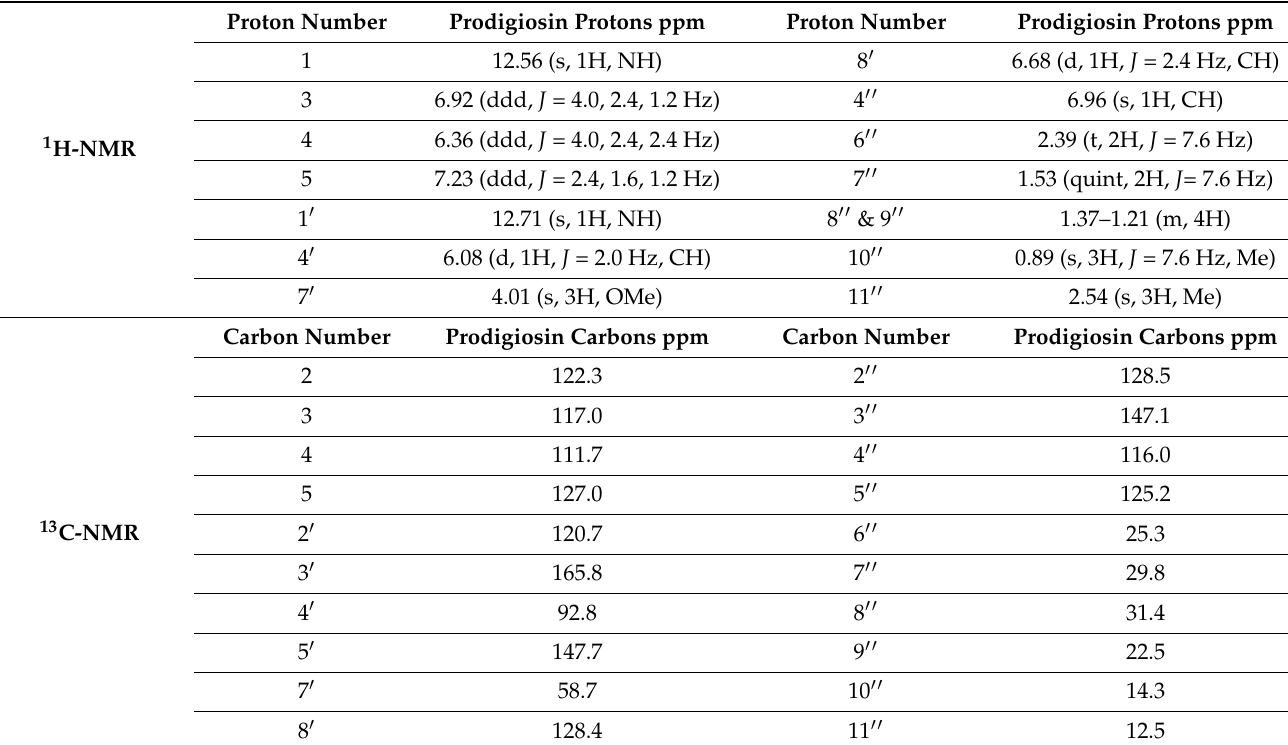
Table 1. 1 H- and 13 C-NMR data for